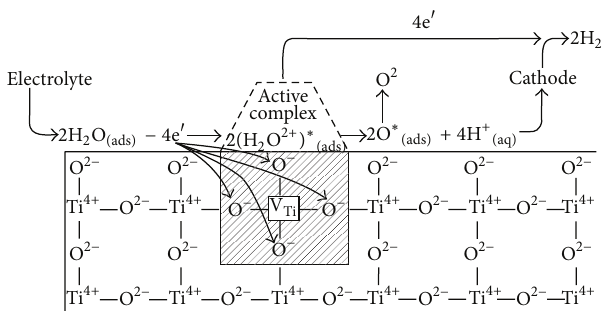
Figure 9: The Ti vacancy functions as the active site